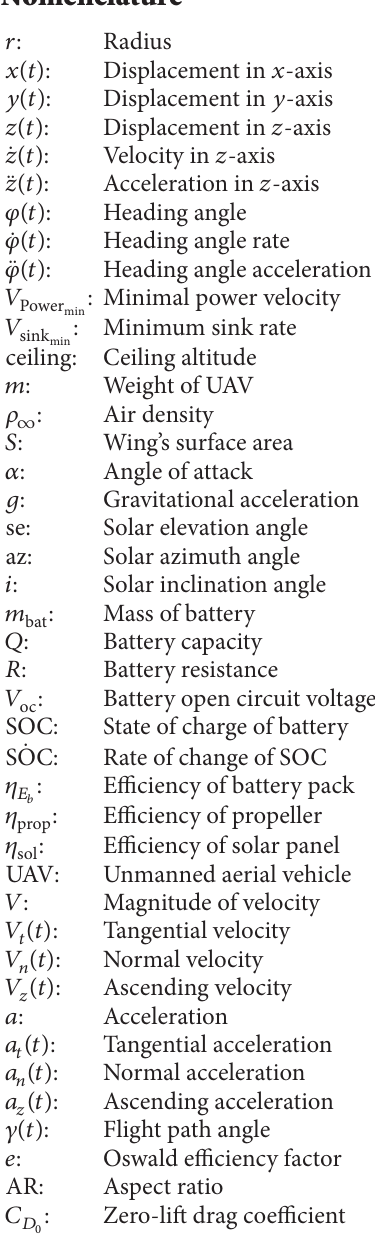
Figure 12: Battery SOC for 72 hours.